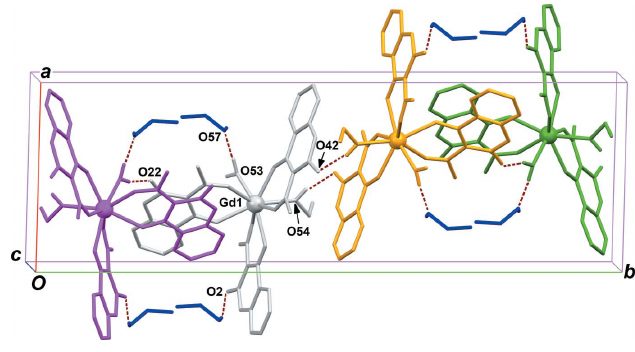
Figure 2 Part of the crystal structure of the title compound, showing the interactions between the lattice solvent (blue molecules) and the complexes, via hydrogen bonds (dashed lines). The colour scheme for the complexes indicates the symmetry operations in P 2 1 / c : grey: asymmetric unit; gold: inversion (1 (cid:5) x , 1 (cid:5) y , 1 (cid:5) z ); green: screw (cid:5) z ); magenta: glide plane ( x , 1 axis (1 (cid:5) x , 1 + y , 3 2 2